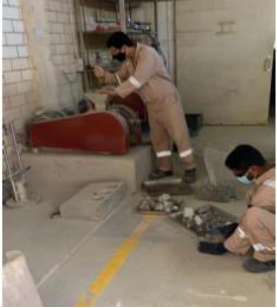
Figure 2. Crushing Machines Figure 3. Putting the concrete cubes in the machine